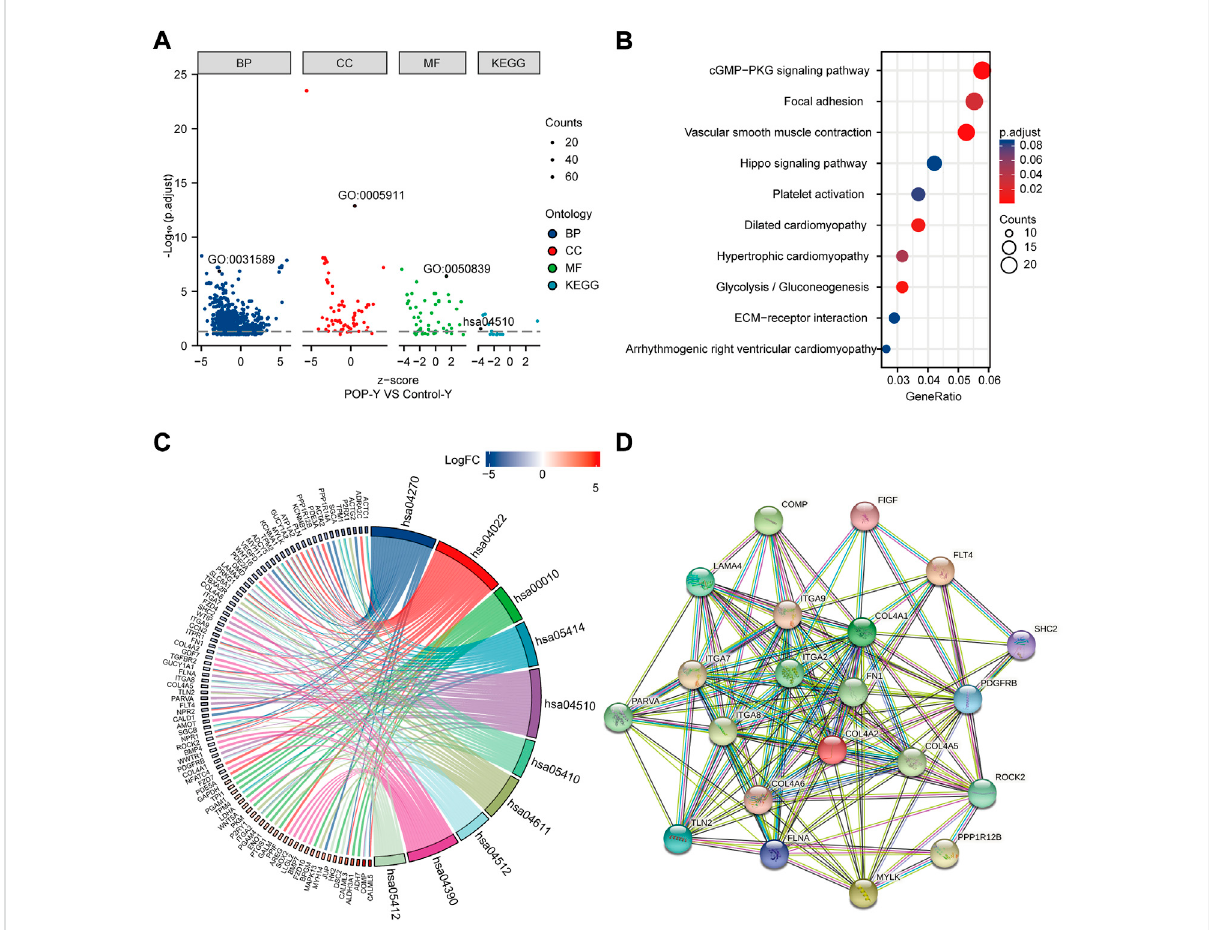
FIGURE 5 Functional enrichment analysis of DEGs using GO and KEGG and the PPI network. (A) Analysis of DEGs using GO and KEGG. (B) Top ten KEGG pathways. (C) Top ten KEGG pathways related to DEGs. (D ) PPI network of focal adhesion pathway hub genes in the KEGG